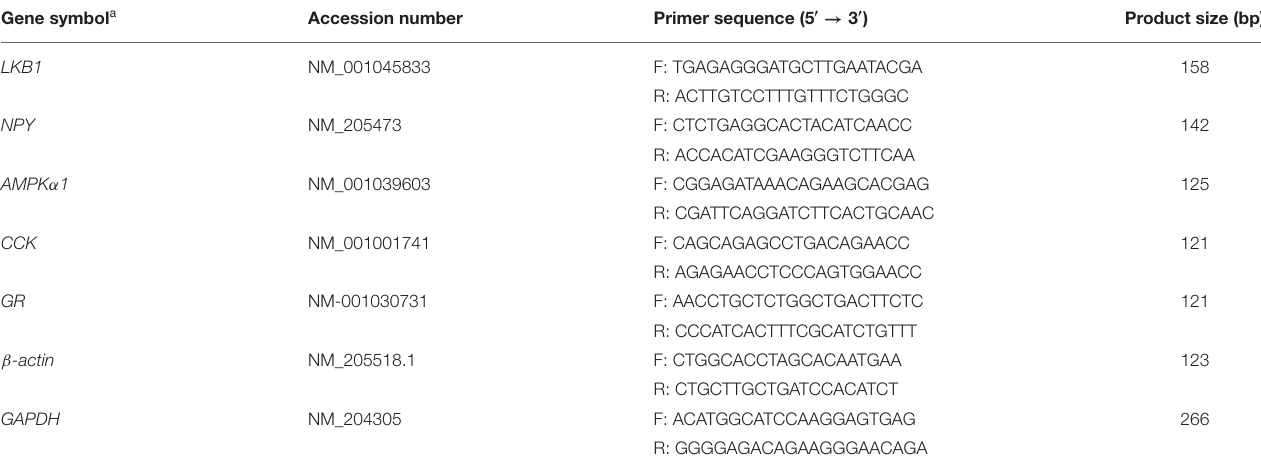
TABLE 2 | Gene-specific